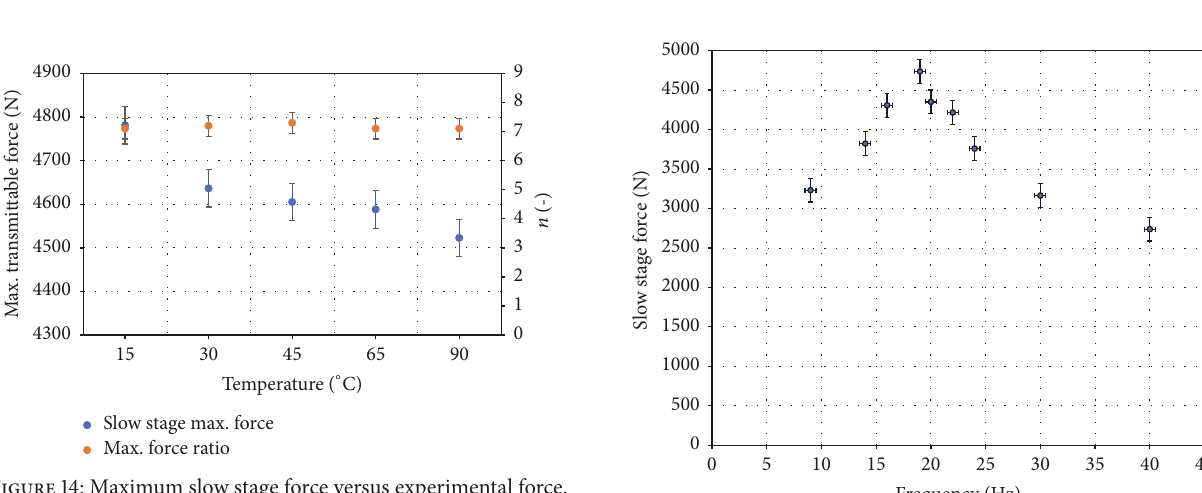
Figure 16: Normalized displacement versus frequency during 𝑍 - transmitter tests.